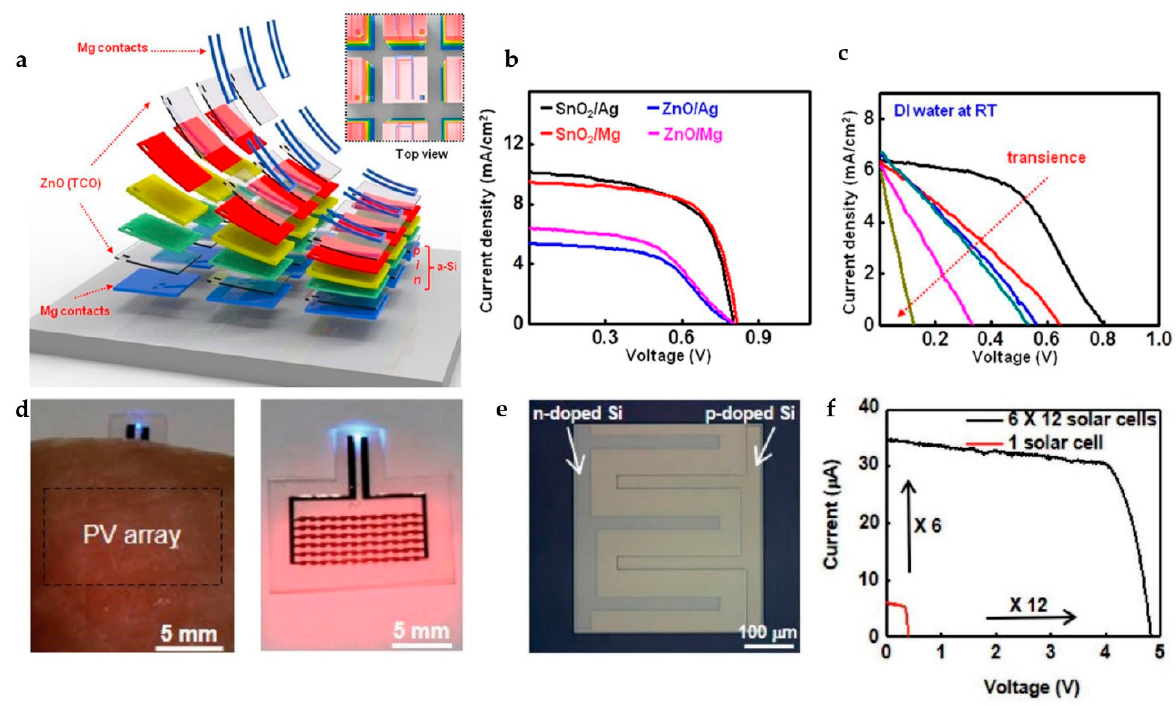
Figure 4. ( a ) Schematic diagram of key materials and structures of biodegradable transient solar cells. ( b ) Comparison of the current/voltage characteristics from a transient amorphous silicon-based solar cell and a nontransient amorphous silicon-based solar cell. ( c ) Current/voltage characteristics of a photovoltaic cell in deionized water at room temperature, revealing its transience behavior. ( a – c ) Reproduced with permission from [55]. ( d ) Optical image of a monocrystalline silicon photovoltaic cell array. ( e ) Optical microscope image of a single bioresorbable microcell. ( f ) Current/voltage characteristics of a single microcell (red) and an interconnected array (black). ( d – f ) Reproduced with permission from [34].